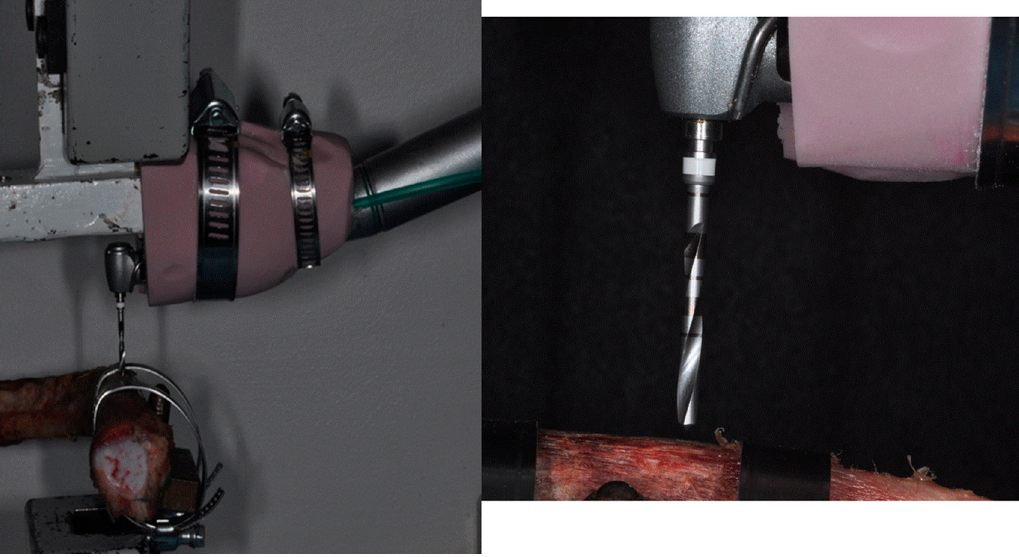
Figure 3. A conventional dental handpiece with a physio-dispenser mounted on a universal testing machine, before the test.